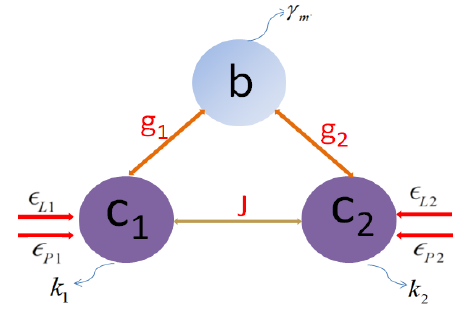
Figure 1. Schematic diagram of the double optomechanical systems: the two optical cavities with optical modes c 1 and c 2 are coupled with a mechanical oscillator with the mechanical mode b . ( p and q are the momentum and position operators of the mechanical oscillator, respectively). The two cavities are coupled with a coupling constant of J , and each cavity is driven by a control field with amplitude (cid:101) Li ( i = 1, 2 ) and a probe field with amplitude (cid:101) Pi ( i = 1, 2 )